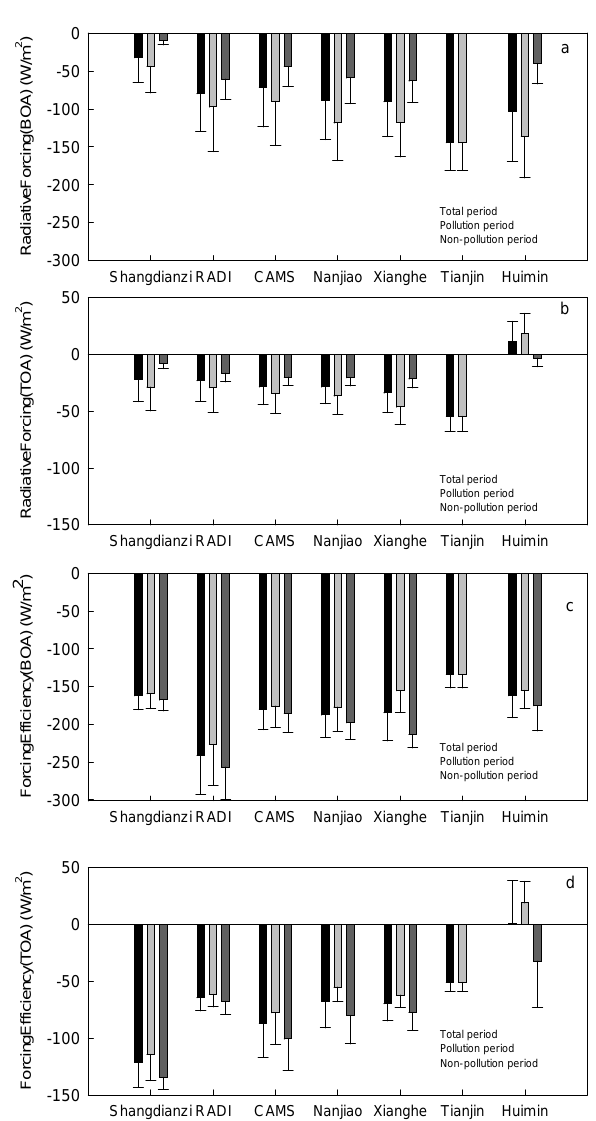
Fig. 9. Means of aerosol radiative forcing during the total period (January 2013), pollution period (daily PM 2 . 5 ≥ 75µgm − 3 ) , and non-pollution period (daily PM 2 . 5 ≤ 75µgm − 3 ) at each site. (a) ARF-BOA, (b) ARF-TOA, (c) efficiency of ARF-BOA, (d) effi- ciency of